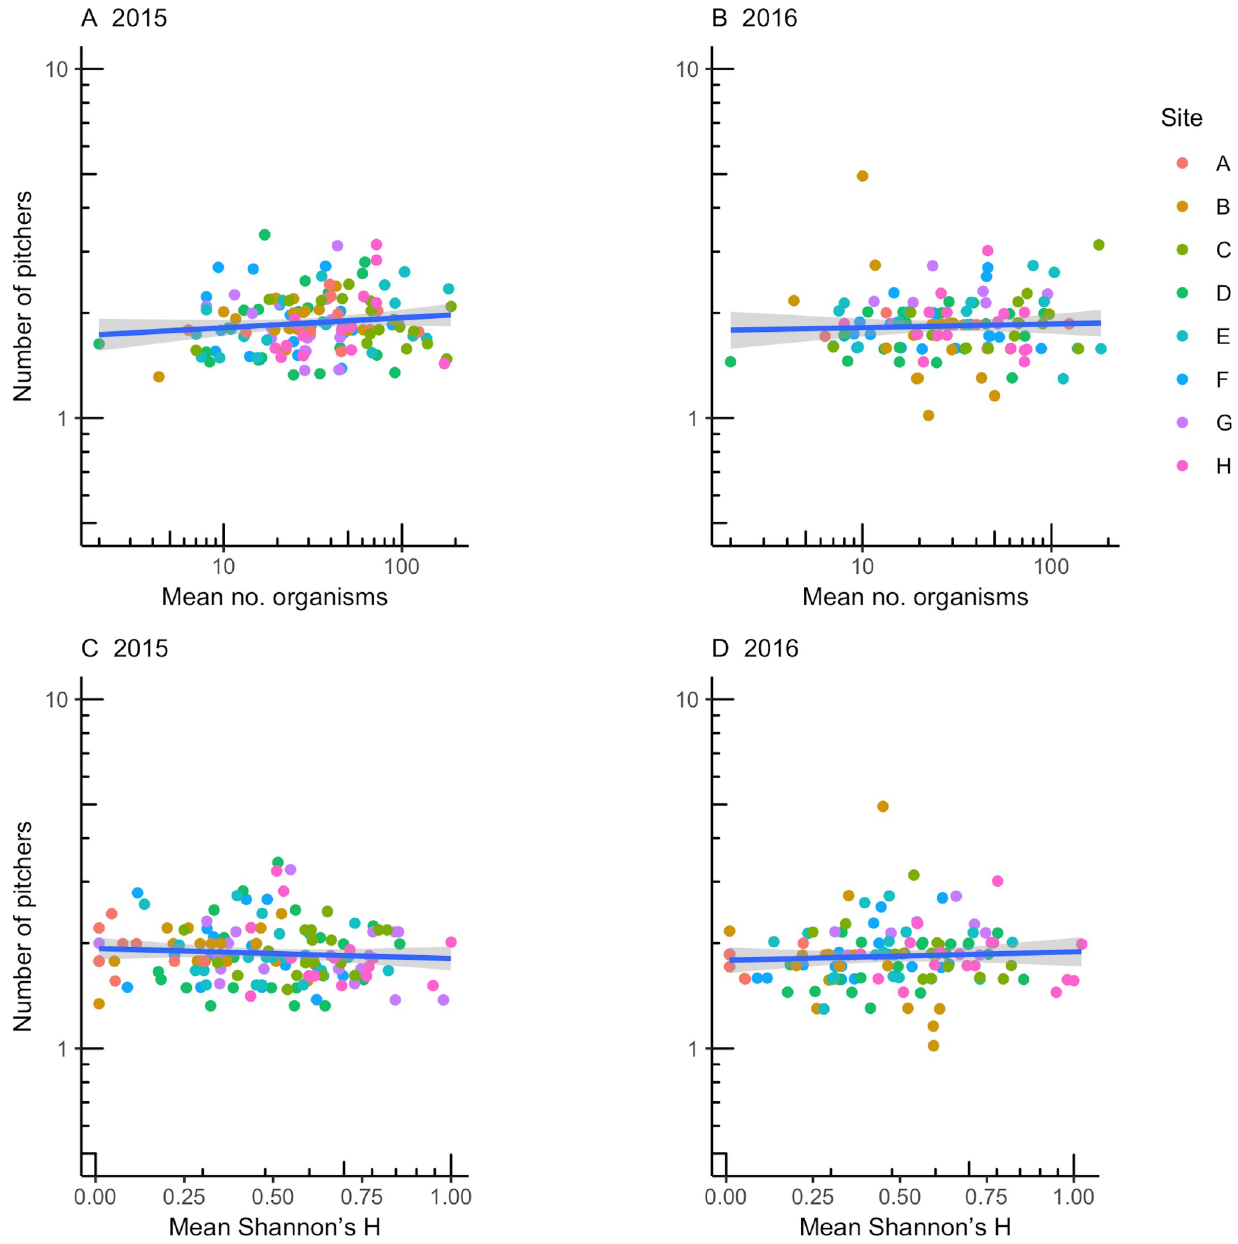
Fig 1. Weak effects of inquiline abundance and community diversity on vegetative growth provide limited support for H1. Number of inquiline organisms (A, B) and community diversity (Shannon’s H; C, D) and their effect on number of pitchers produced in 2015 and 2016. Total organisms and Shannon’s H were measured in 2015. Points are the grand mean number of pitchers plus residuals from models in Table 3. For A and B, residuals were obtained from models f and g , respectively. For C and D, residuals were obtained from models o and p , respectively.